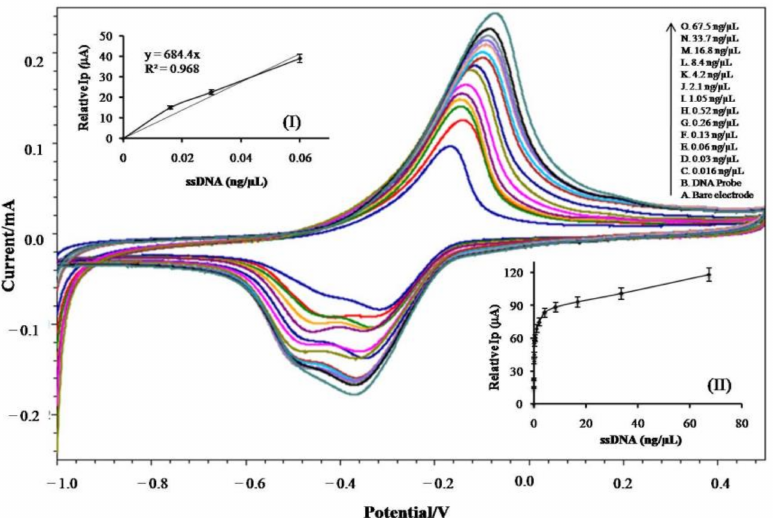
Figure 3. Voltammetric analysis of the developed DNA sensor in different phases of the fabrication, including (A) the AuN/CNF electrode (bare), (B) AuN/CNF/ssDNA (probe), and (C–O) hybridiza- tion with single-stranded GDNA of Leptospira interrogans . The insert ( I ) shows a linear curve for the calculation of the limit of detection (LOD) and ( II ) shows a hyperbolic curve plotted between the relative peak current Ip with respect to probe with different concentrations of hybridizing ssGDNA of L. interrogans .